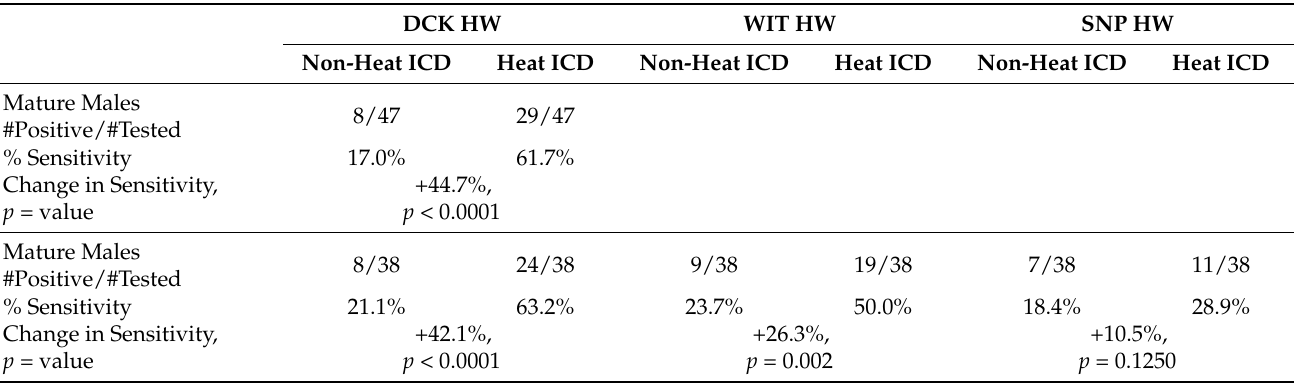
Table 1. Test sensitivity for heartworm antigen detection pre- and post-heat ICD of serum from dogs with mature male-only heartworm infections. DCK HW WIT HW SNP HW Non-Heat ICD Heat ICD Non-Heat ICD Heat ICD Non-Heat ICD Heat